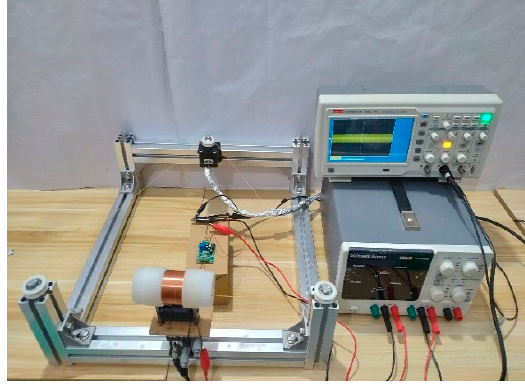
Figure 7. Experimental rig.